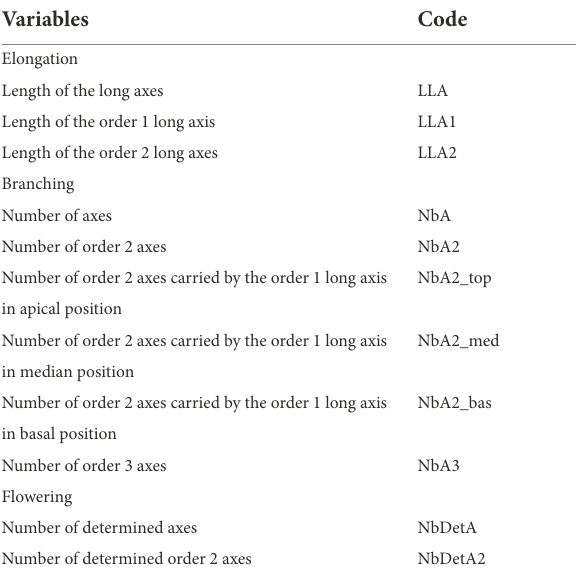
TABLE 2 List of the architectural variables measured at the ‘VFB of the order 2 axes carried by the order 1 long axis in apical position’ stage, according to three pre-defined categories (elongation, branching and